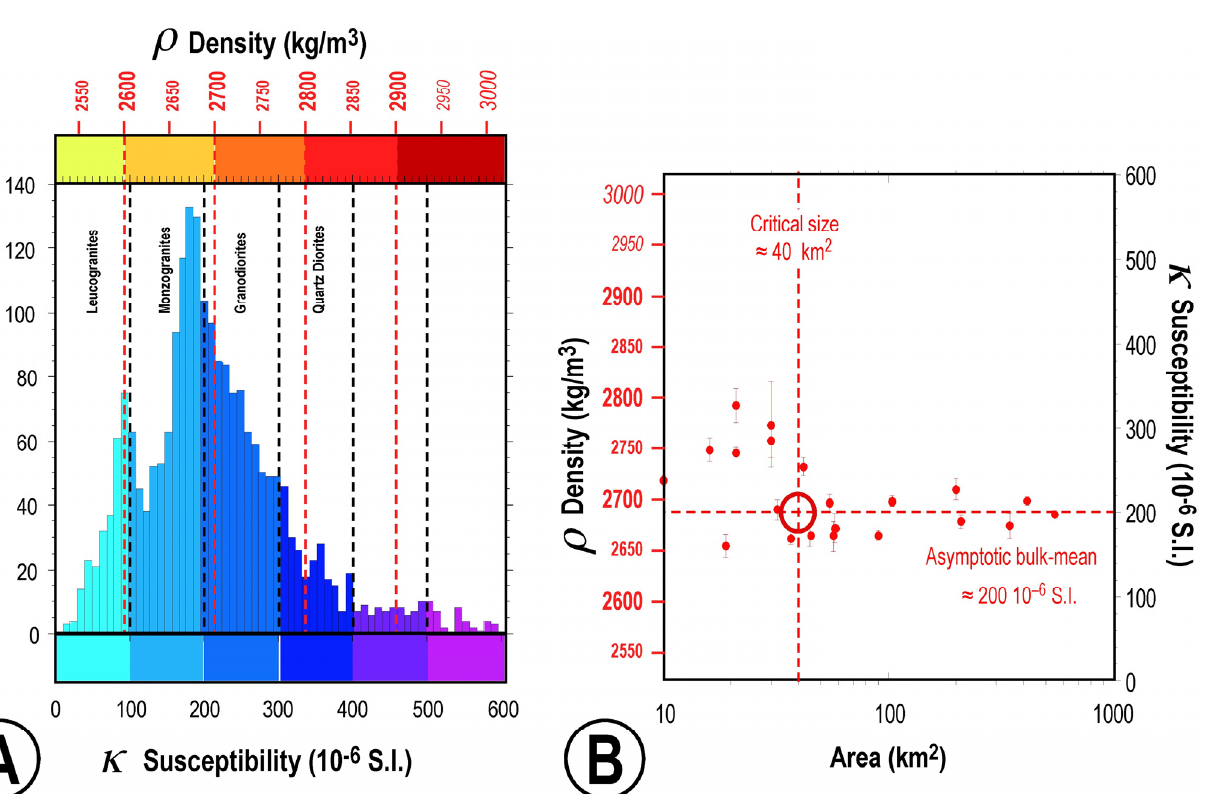
Figure 12. Geochemical data (% in wt of SiO 2 , Al 2 O 3 , Fe 2 O 3 and Ti0 2 ) against rock density ( ρ ) and magnetic susceptibility ( κ ) as well as the linear regressions stablished among them in some type-2 samples frm Maladeta and Mont Louis Andorra plutons.